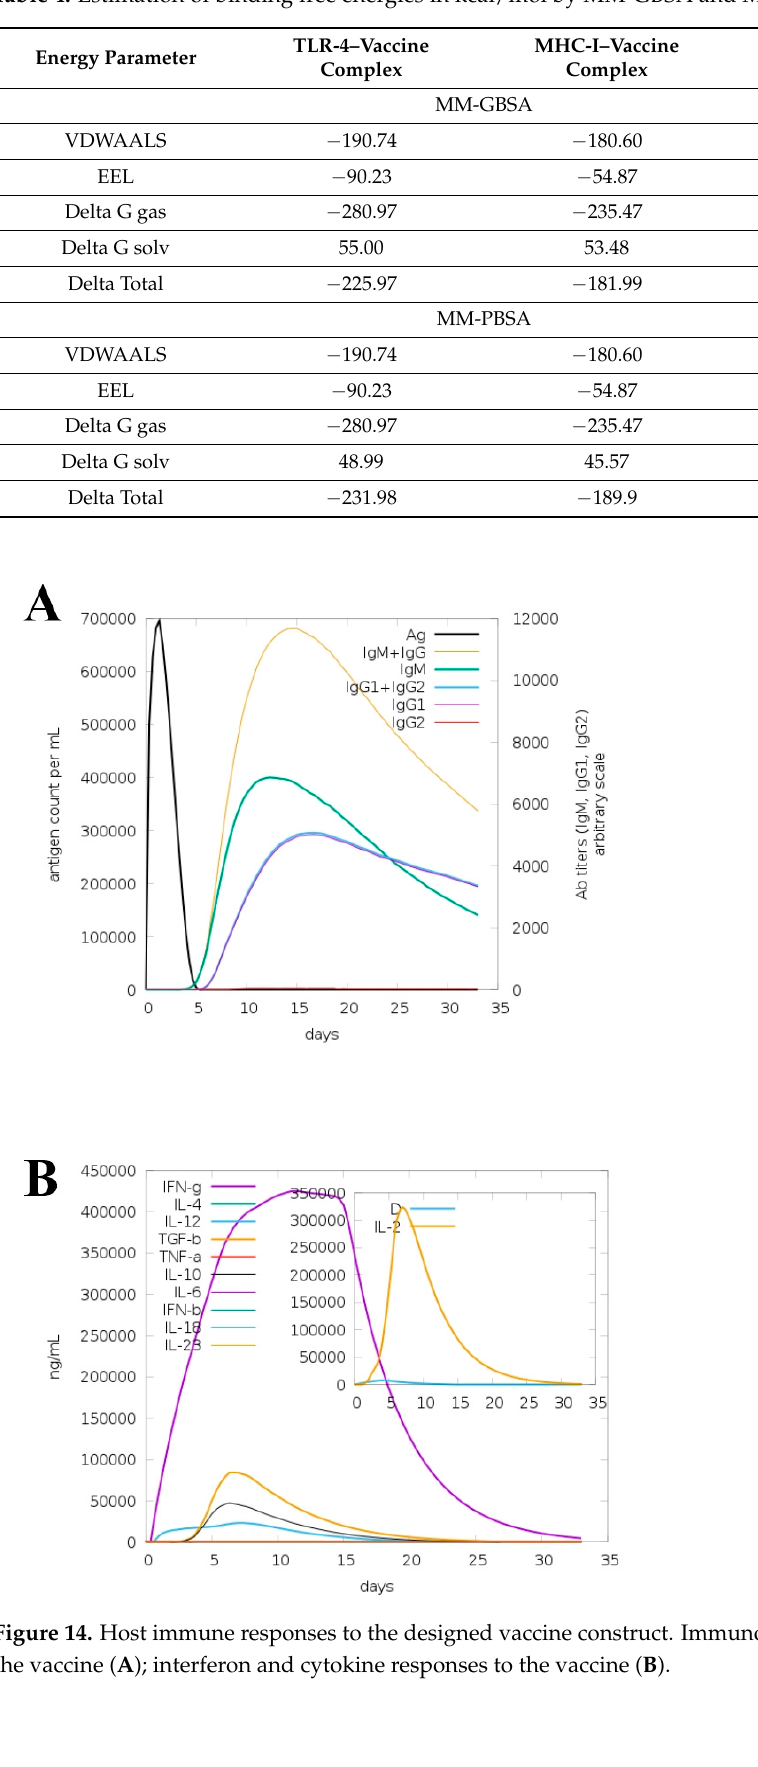
Table 4. Estimation of binding free energies in kcal/mol by MM-GBSA and MM-PBSA methods.